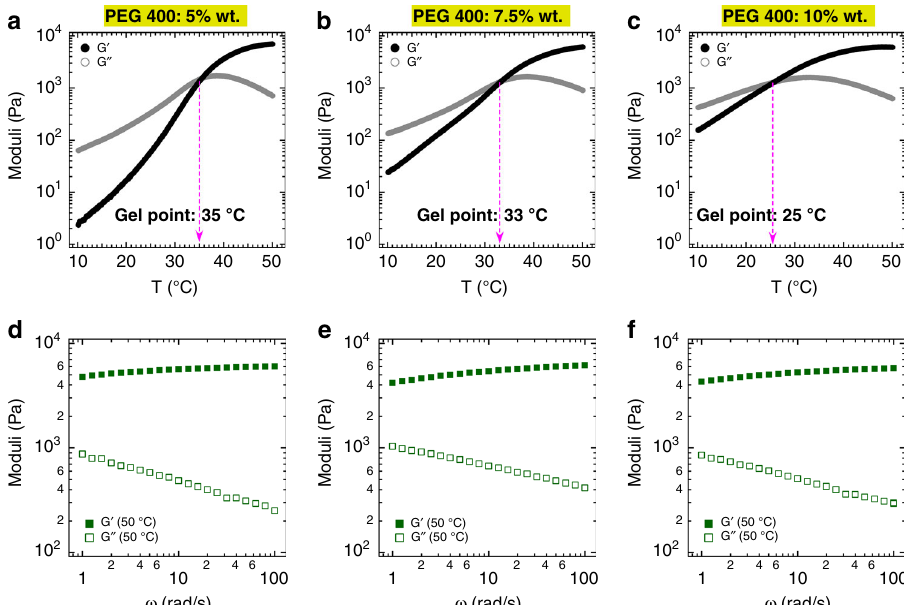
Fig. 5 Effect of cosurfactant PEG 400 concentration on rheological properties and gelation temperature T gel . Shear moduli as a function of temperature and frequency at 50 °C. Nanoemulsion droplet size (hydrodynamic diameter of 53 nm) and volume fraction ( ϕ = 0.24) are kept constant for all formulations. The only difference in the chemical composition of the samples is the amount of added cosurfactant (PEG 400). The top panels a – c show the evolution of the dynamic moduli in a small amplitude oscillatory shear temperature ramp experiment and bottom panels d – f show frequency sweep test at 50 °C for the same systems. The pink lines with arrows in a – c mark the intersection of G ′ and G and indicate the gel